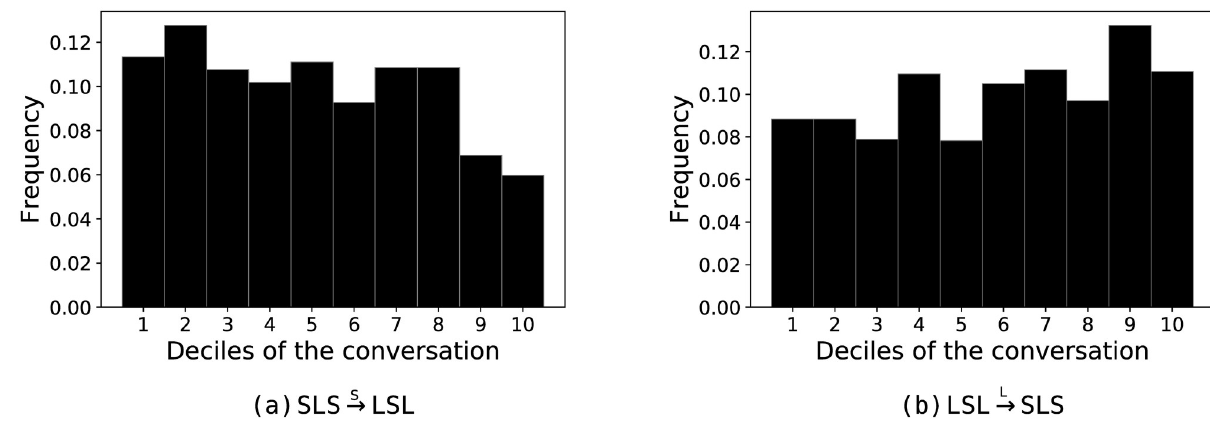
Fig 4. Temporal changes in 1-way information flow in the PCCRI corpus. Histograms of temporal changes in transition frequencies for patient turns in 3 rd -order CODYMs for one-way information exchanges (a) from patient-to-clinician, and (b) from clinician-to-patient, over 10 conversational deciles that were subsequently averaged over all conversations in the PCCRI corpus and normalized, such that the sum of all bins is 1.0.